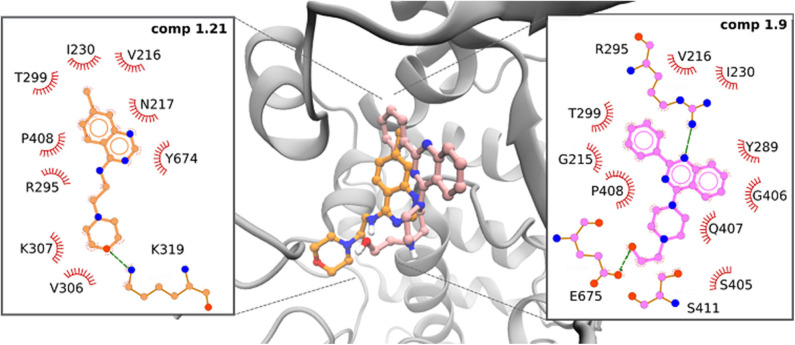
Predicted interactions of active compounds 1.9 (pink) and 1.21 (orange) within the allosteric site of BVDV RdRp protein obtained by MD simulations.